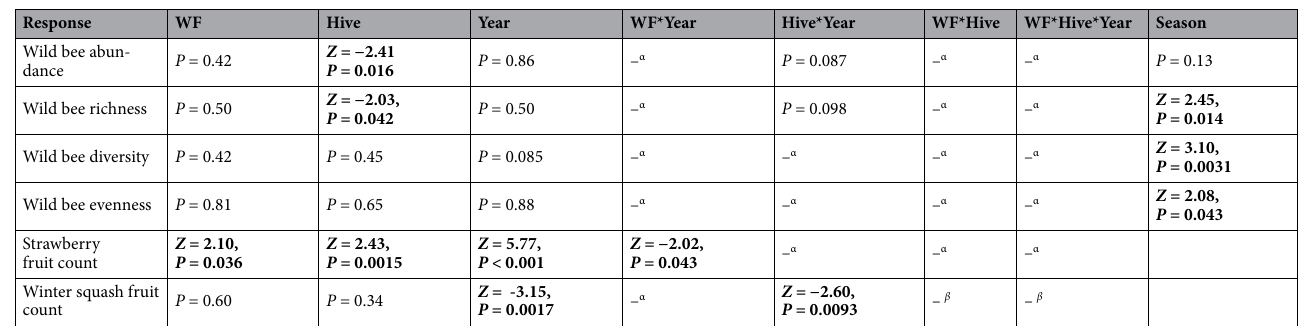
Table 1. Wild bee survey data (abundance, species richness, Shannon–Wiener diversity, and species evenness) and fruit count data in response to wildflower strip (WF) and hive presence/absence, year, and/or